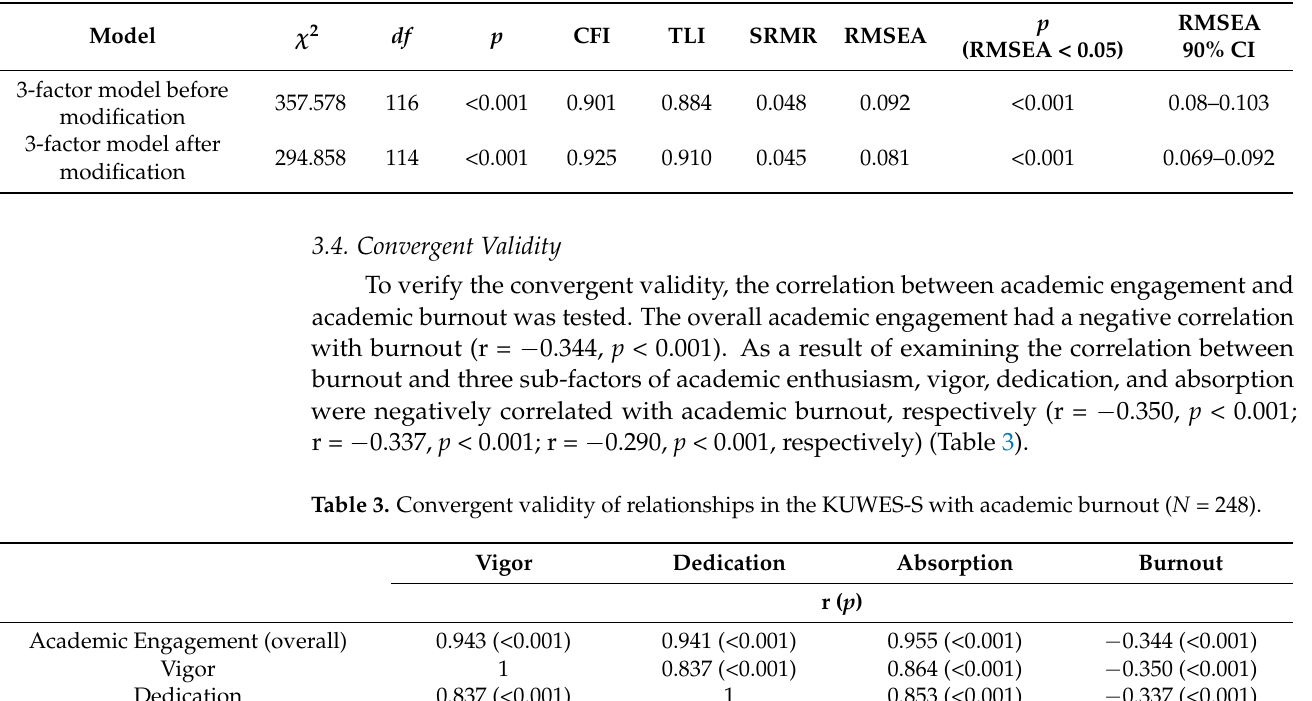
Table 2. Fit indices from the CFA model of the KUWES-S ( N = 248).